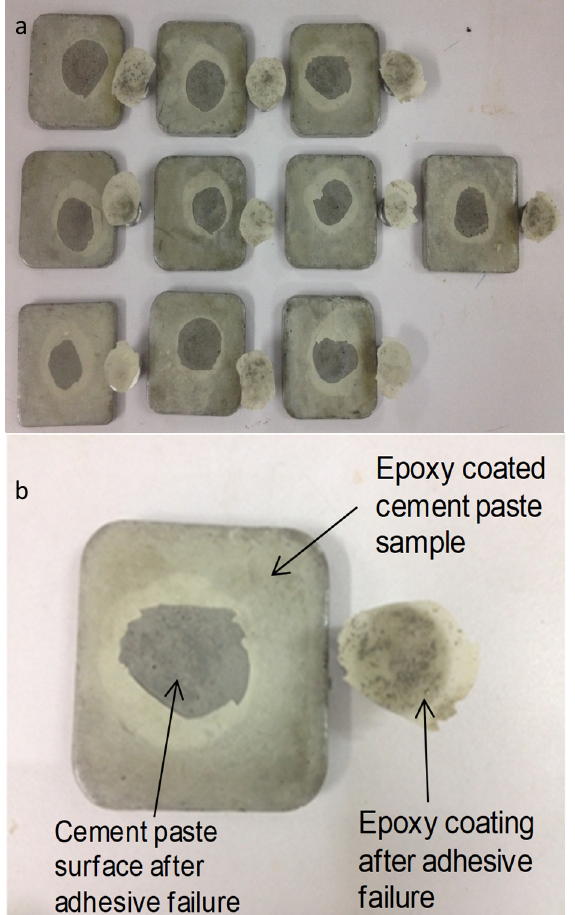
Figure 1. Adhesive (interfacial) failure observed in the pull ‐ off adhesion test experiments for (a) a set of samples considered for 28 days of hydration and 50 th day strength tests and (b) individual sample.